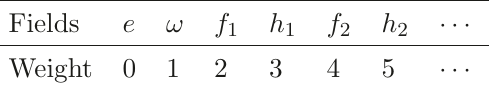
Table 1 . Form fields and their